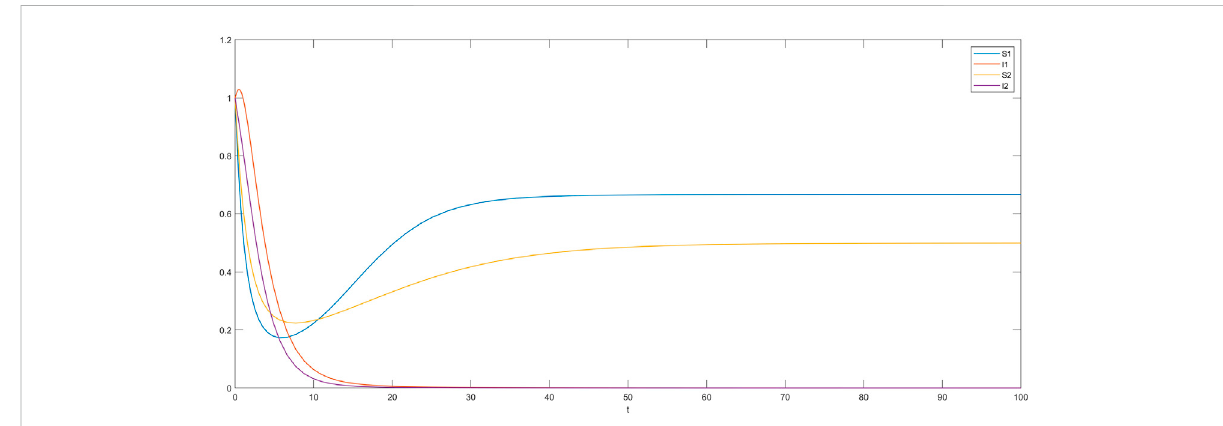
FIGURE 1 Stability of panic-free equilibrium when R 0 < 1.